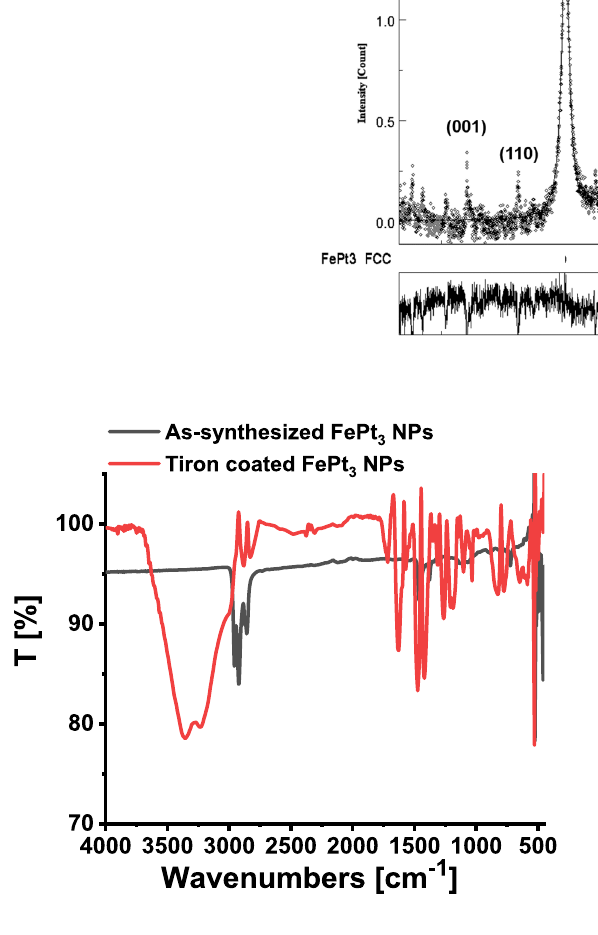
Fig. 4 FTIR-ATR transmission spectra of the as-synthesized FePt NPs (black solid line) and tiron-coated FePt